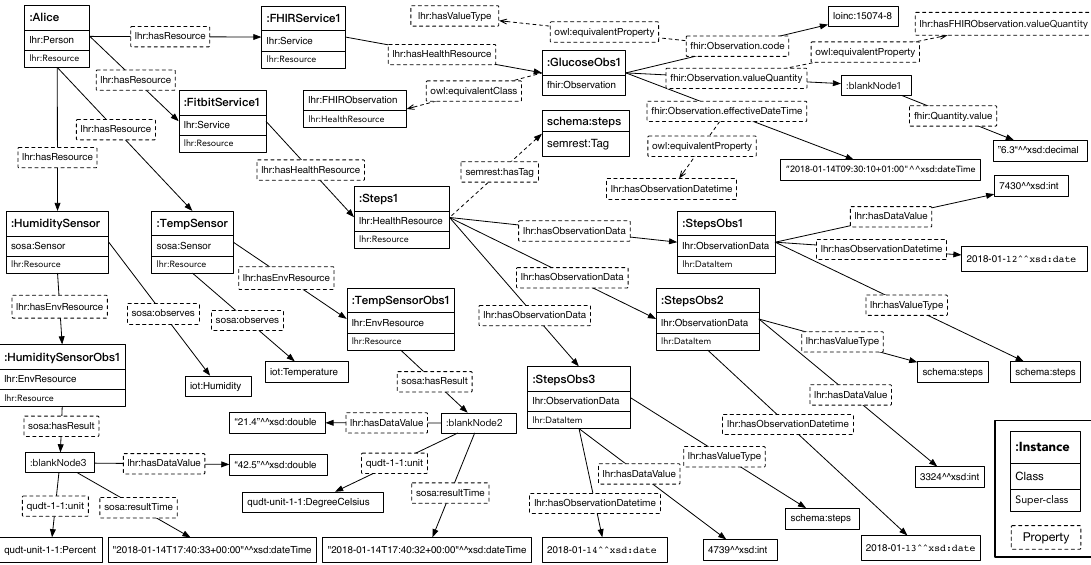
Figure 5. Graphical presentation of Alice’s integrated health and home environment resources under the LHR ontology, where each instance’s class or property is presented with super-class or